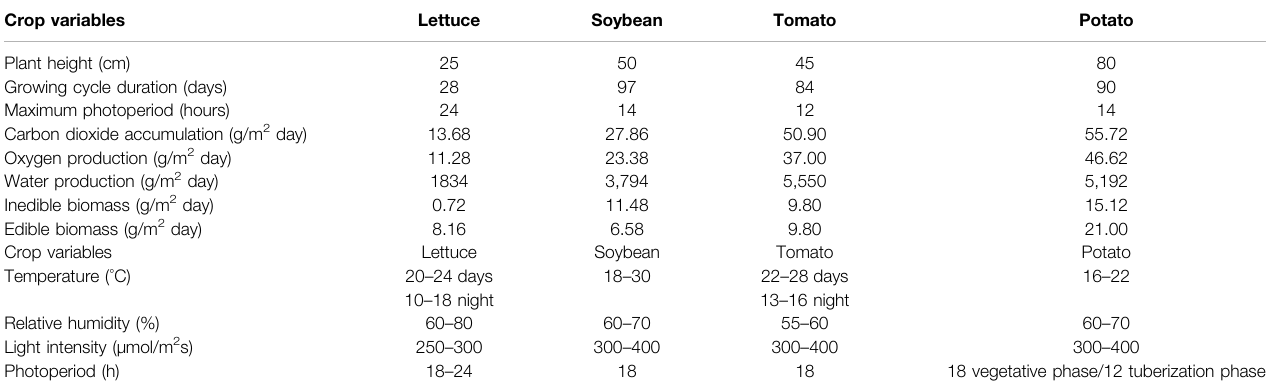
TABLE 2 | Main characteristics of the four crops proposed as candidates for PCU life tests (left panel; data elaborated from literature on plant cultivation in controlled environment for Bioregenerative Life Support Systems), and optimal ranges of air temperature, relative air humidity, and light intensity and photoperiod for the crops suggested to validate the PCU design (right panel).